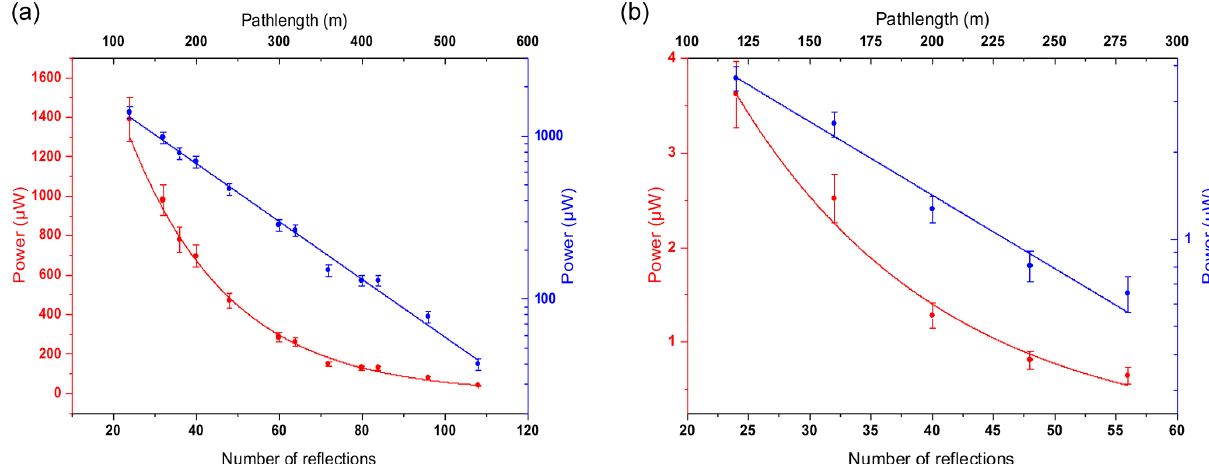
Figure 3. Attenuation of the IR (a) and the THz (b) output power (linear scale in red, log. scale in blue) vs. the number of the reflections in MULTICHARME. The effective IR and THz reflectivities are deduced from the fit of the measurements with the power law: P = A × R n (power law fit in red, linear fit in blue). The fits are performed with an instrumental weighting ω i = 1 /σ 2 taking into account: the IR sensor uncertainty (5%) and the accuracy of the controller sensor (3%) for (a) ; the THz power fluctuations measured on the lock-in amplifier for (b) . See Fig. S4 for spot matrix